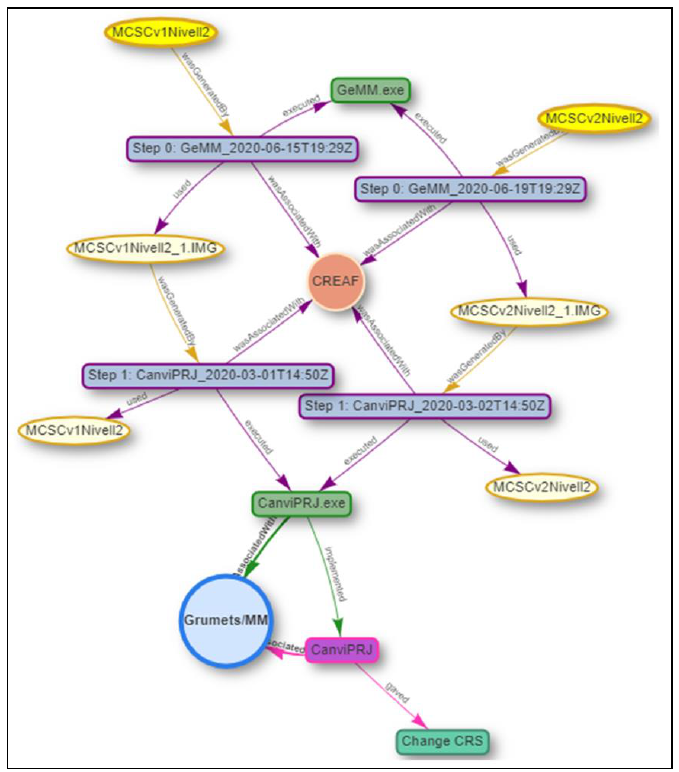
Figure 12. Provenance of the MCSC versions 1 and 2 merged together.